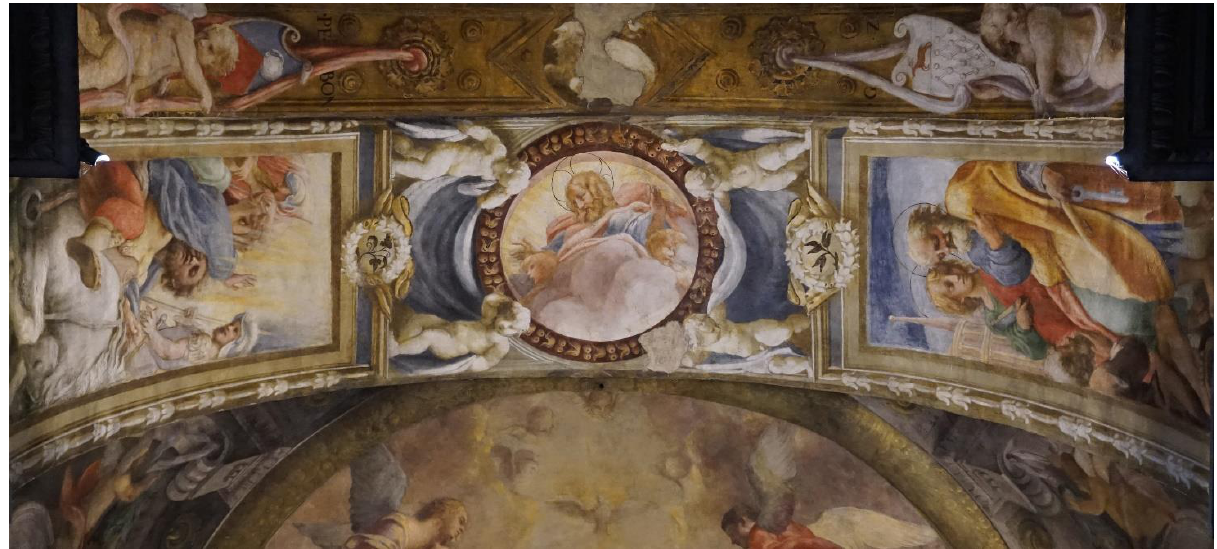
Figure 1. A view of the wall paintings of the sub-arch of Del Bono Chapel in the Abbey Church of S. Giovanni Evangelista in Parma, Italy, representing the Eternal Father (in the center ), the Fall of St. Paul (on the left ) and Saints Peter and Andrew (on the right ) .